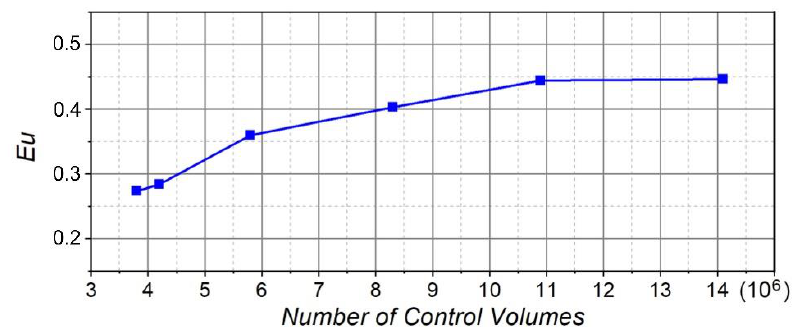
Figure 5. Eu at mesh independence analysis.